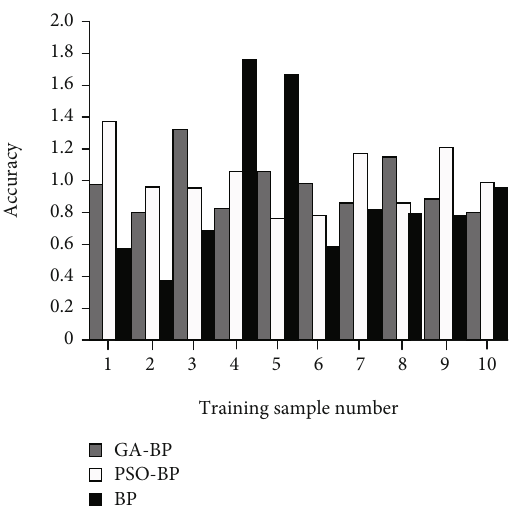
Figure 5: Training output error of di ff erent models.